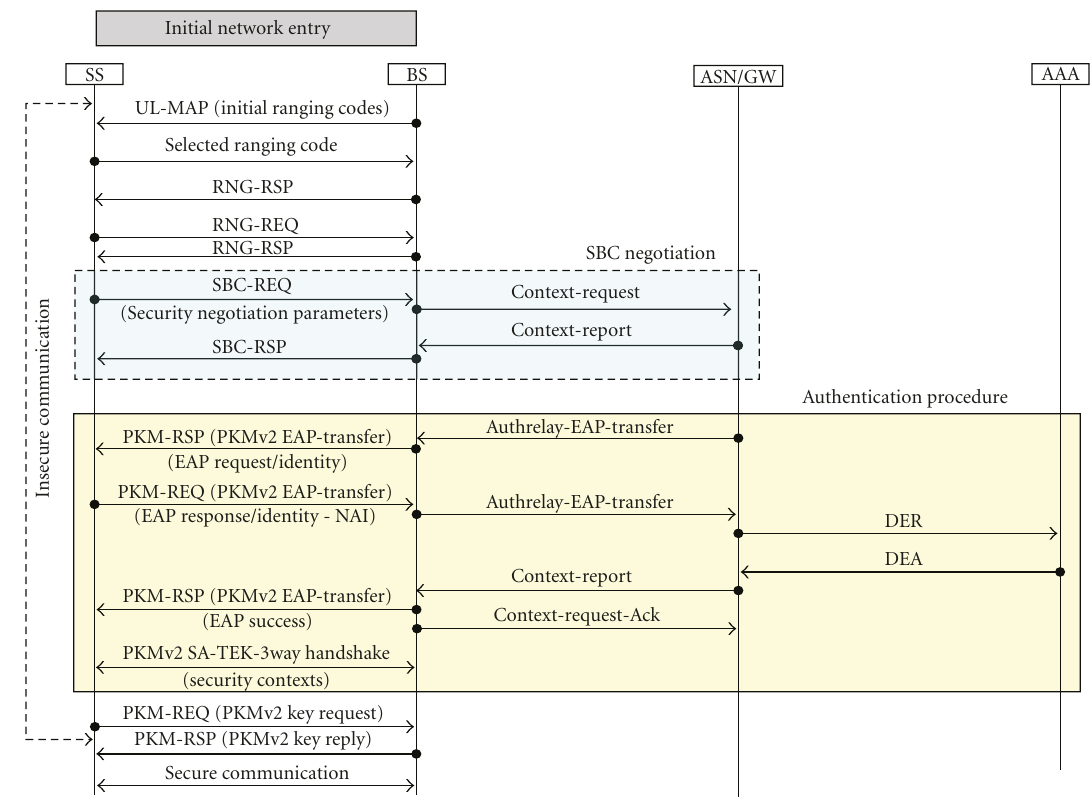
Figure 1: Overview of initial network entry procedure.